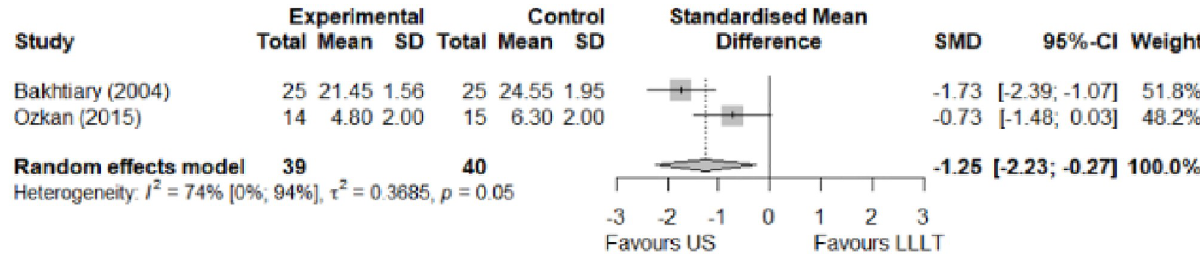
Fig 26. Analysis—Comparison between electrophysical modalities (grip strength).